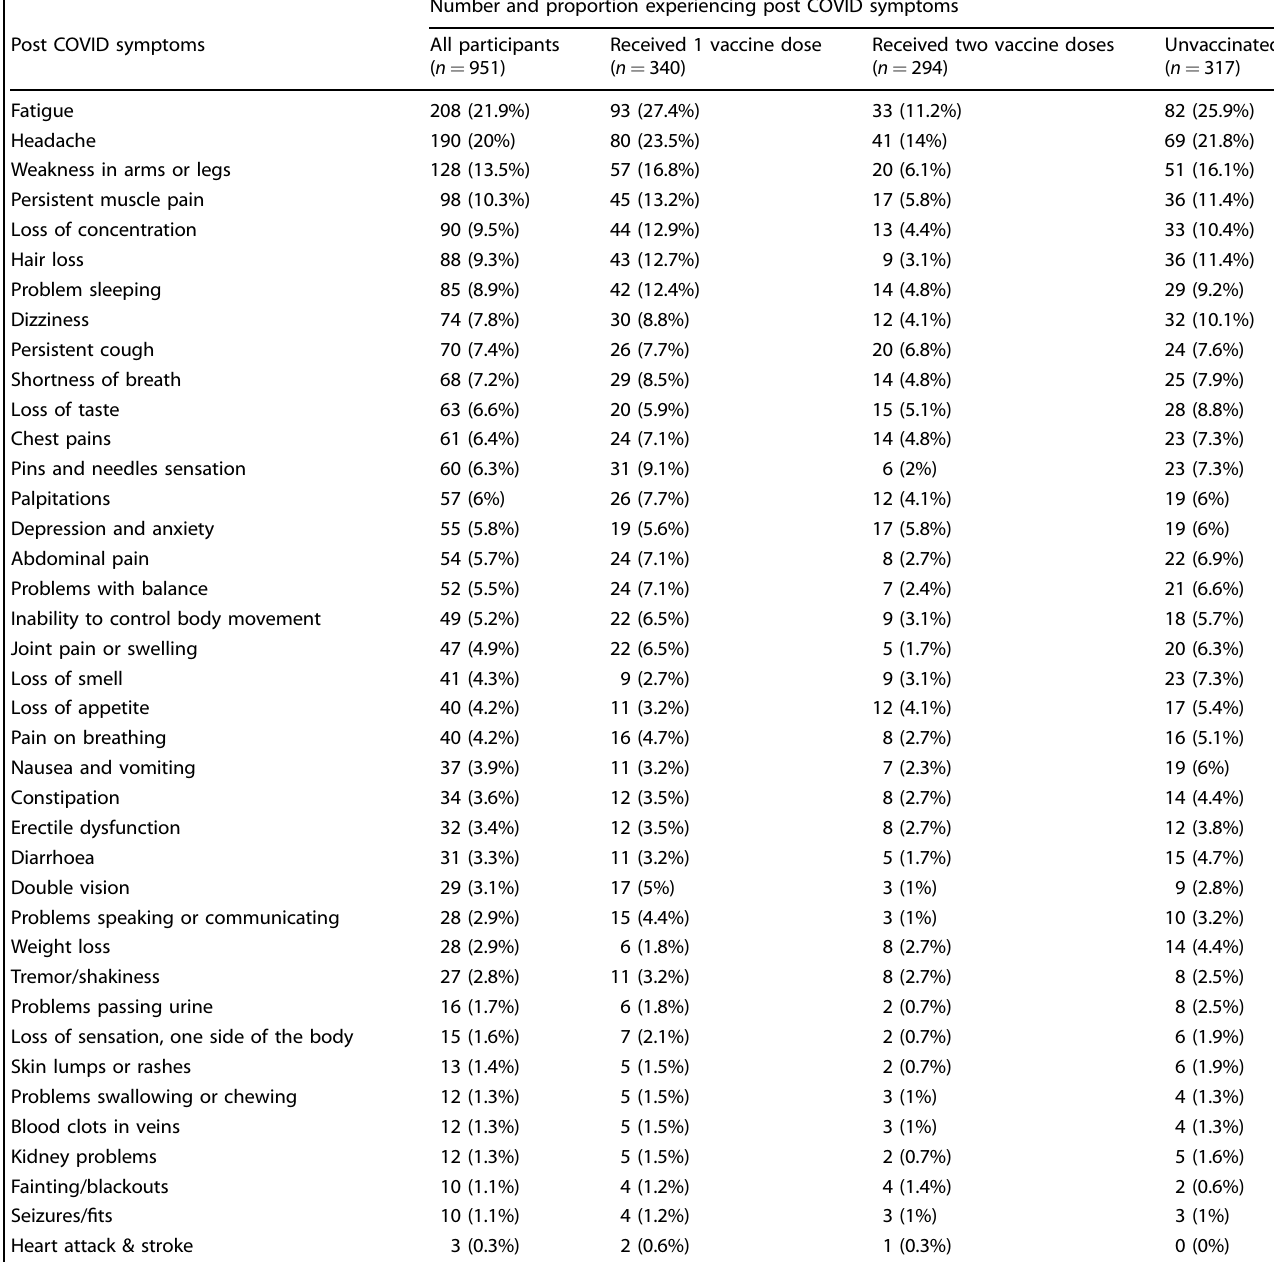
Table 2. Post COVID-19 symptoms among vaccinated and unvaccinated